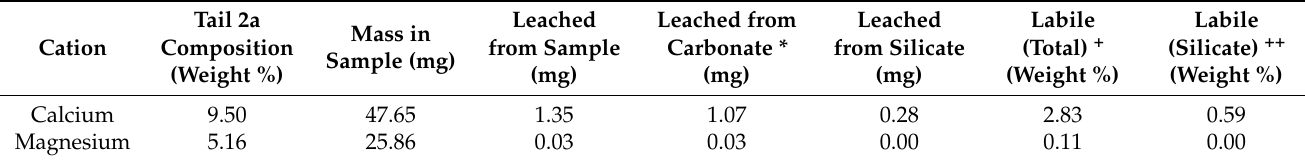
Table 8. Final cation leaching results from the flow-through dissolution experiment of Tail